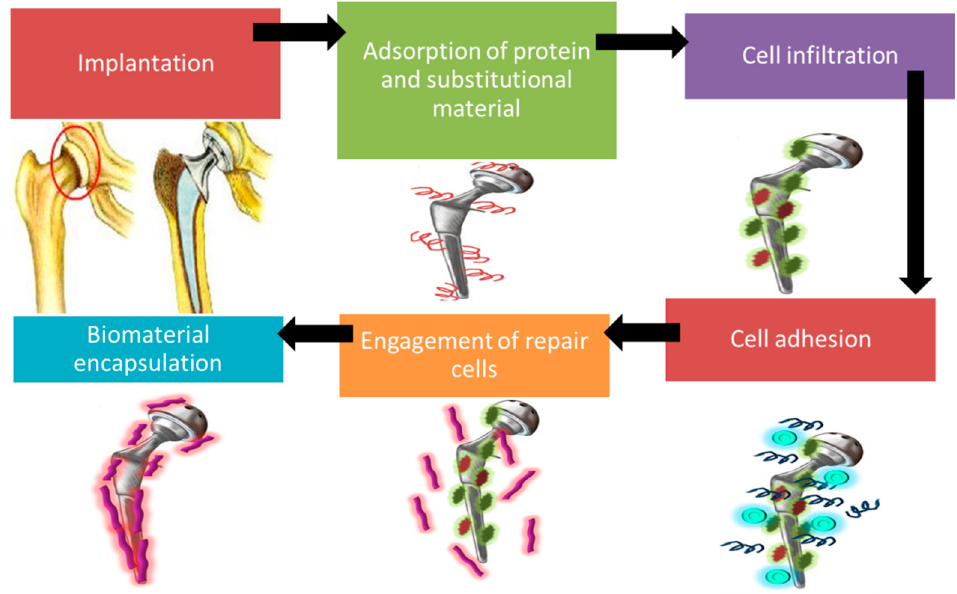
Figure 8. Schematic illustration of natural instinctive immune reaction after a implantation is performed. It includes the adsorption of proteins (occurs at interface level), cell infiltration (occurs only on porous material), cell adhesion which releases cytokines and chemokines, involvement of repair cell, and encapsulation of biomaterial surface.